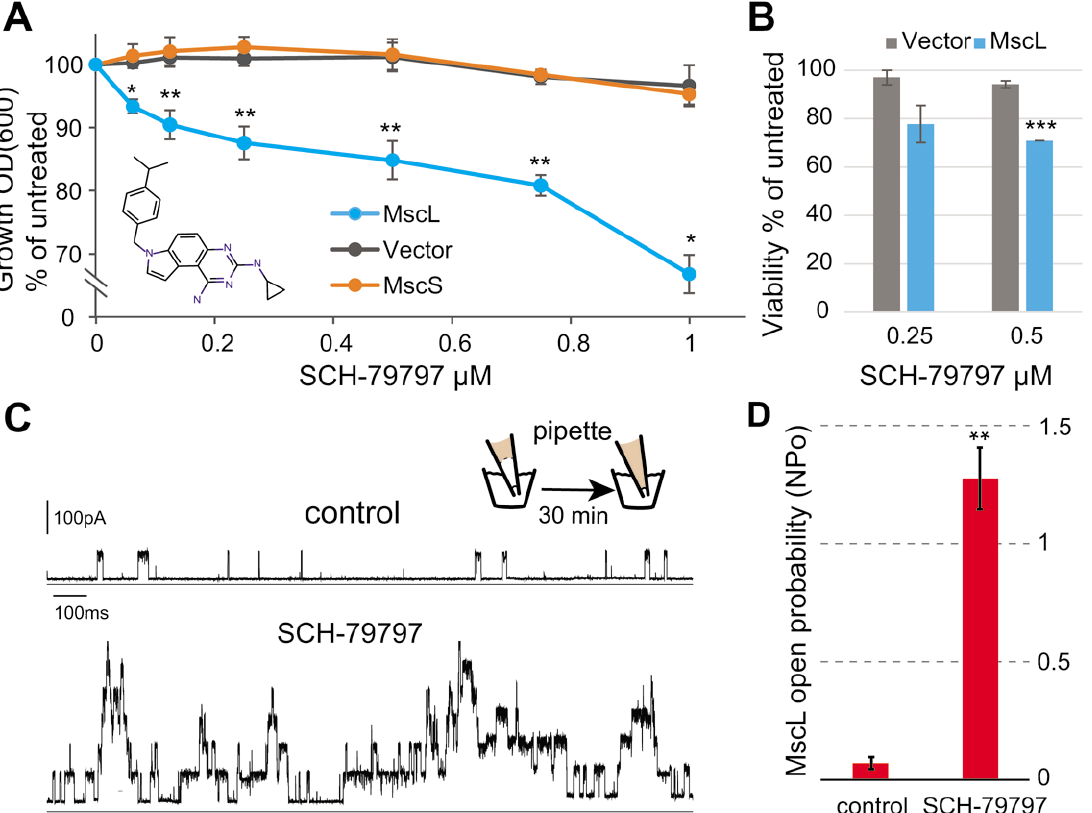
Figure 2. The antibiotic effects of SCH-79797 in vivo are dependent on MscL expression. ( A ) E. coli strain MJF455 ( ∆ MscS, ∆ MscL) cultures carrying an empty vector (gray), expressing MscS (orange), or expressing MscL (cyan) were treated with increasing concentrations of the compound SCH-79797 (insert). The graph represents growth inhibition as a percentage of the non-treated cultures ( n = 4) * p < 0.05, ** p < 0.005. ( B ) Viability of E. coli MJF455 cells, carrying an empty plasmid (gray) or expressing MscL (cyan) after treatment with SCH-79797. Results are graphed as a percentage of the untreated cultures *** p < 0.0001 Student t -test MscL vs. vector. ( C ) Representative traces of MscL activity recorded by a patch clamp on native bacterial membranes. Experiments were performed using the back-filled pipette configuration (scheme), where channel activity was measured shortly after patch formation (control, upper trace ) and then again after diffusion of the compound to the pipette tip ( lower trace ). The same patch was recorded at the same negative pressure before and after treatment. ( D ) Quantification of the channel activity is shown as the probability of opening (Npo) of the MscL channel before and after treatment while held at the same pressure ( n = 4). ** p < 0.003 Student t -test paired treated vs.